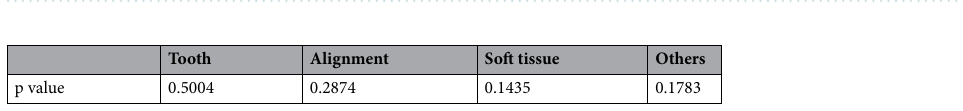
Figure 4. Ratio of each element used for criteria to assess whether the given image is real or generated. Most of the dentists used teeth to discriminate images.